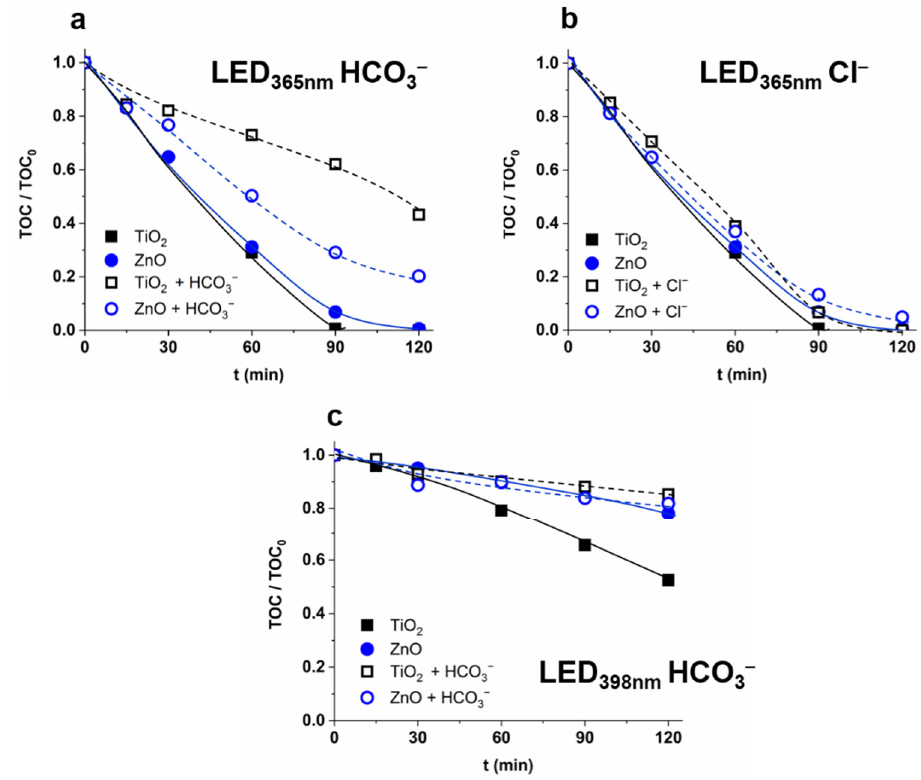
Figure 4. The effect of HCO 3 − (525 mg dm − 3 ) ( a , c ) and Cl − (120 mg dm − 3 ) ( b ) on the mineralization of COU (c 0 = 5.0 × 10 − 4 M; TOC 0 = 55 mg dm − 3 ). In suspensions containing both Cl − and HCO 3 − , the synergistic effect of the anions was not observed. In the case of 365 nm radiation, the negative effect of HCO 3 − on r 0COU was dominant. At the same time, for ZnO, the Cl − effect while for TiO 2 the HCO 3 − effect was dominant on the r 07-HC (Figure 3c). The extent of the effect depended on the wavelength; in the case of LED 398nm , only a slight reduction of reaction rates was observed (Figure 3d). Comparing the effect of anions and their mixtures to the tap water